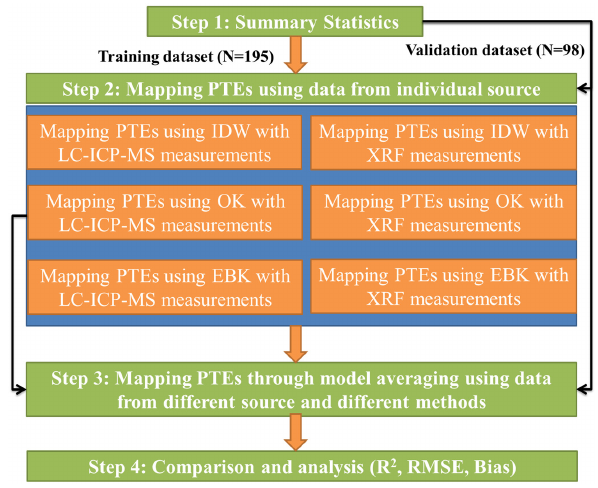
Figure 2. Flowchart of methods used in this